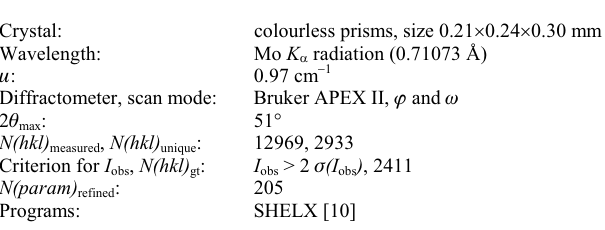
Table 1. Data collection and handling.